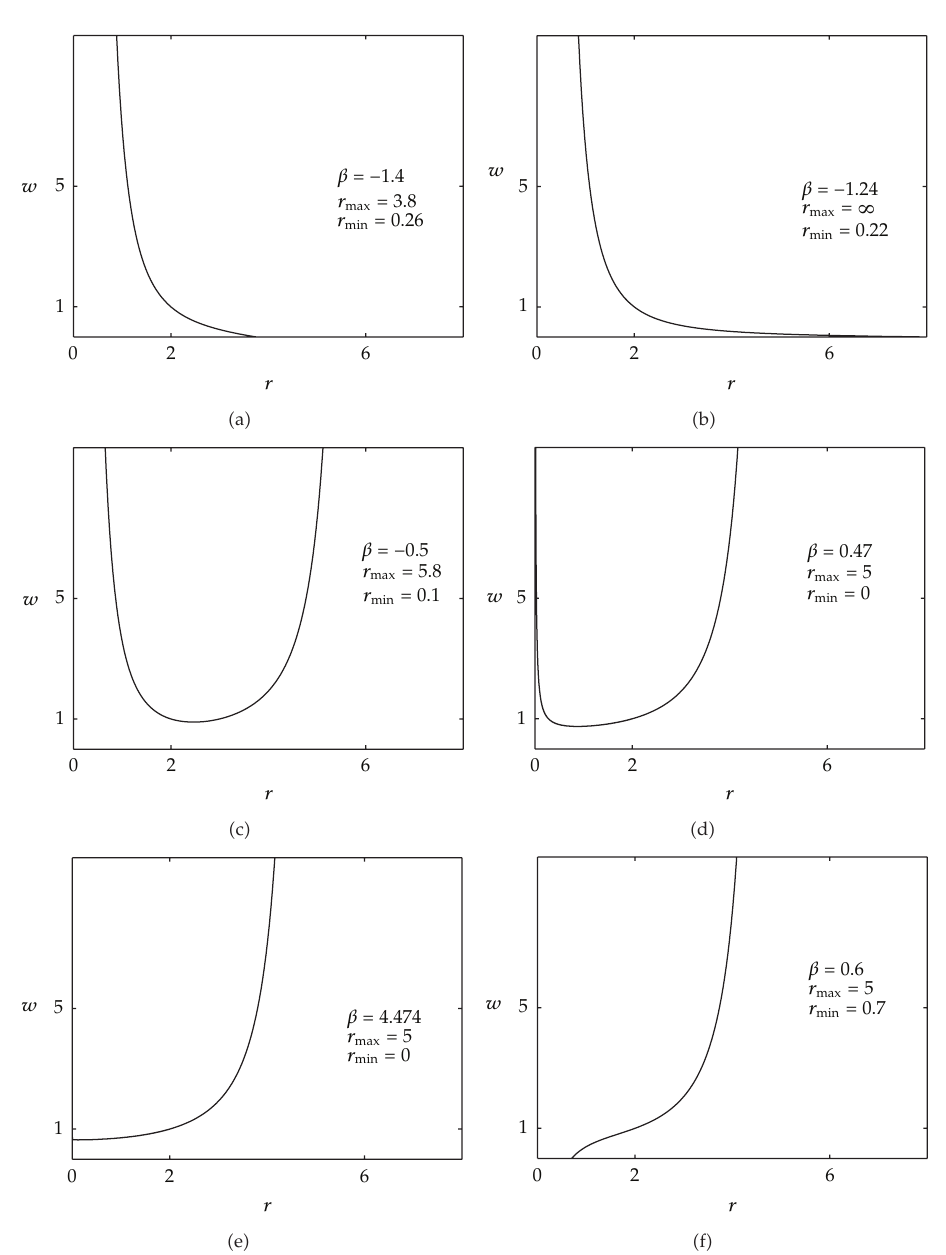
Figure 1: Solutions of (cid:3) 1.3 (cid:4) – (cid:3) 1.8 (cid:4) for various β values when (cid:3) N,p,r 0 ,α (cid:4) (cid:5) (cid:3) 3 , 2 , 2 , 2 (cid:4)